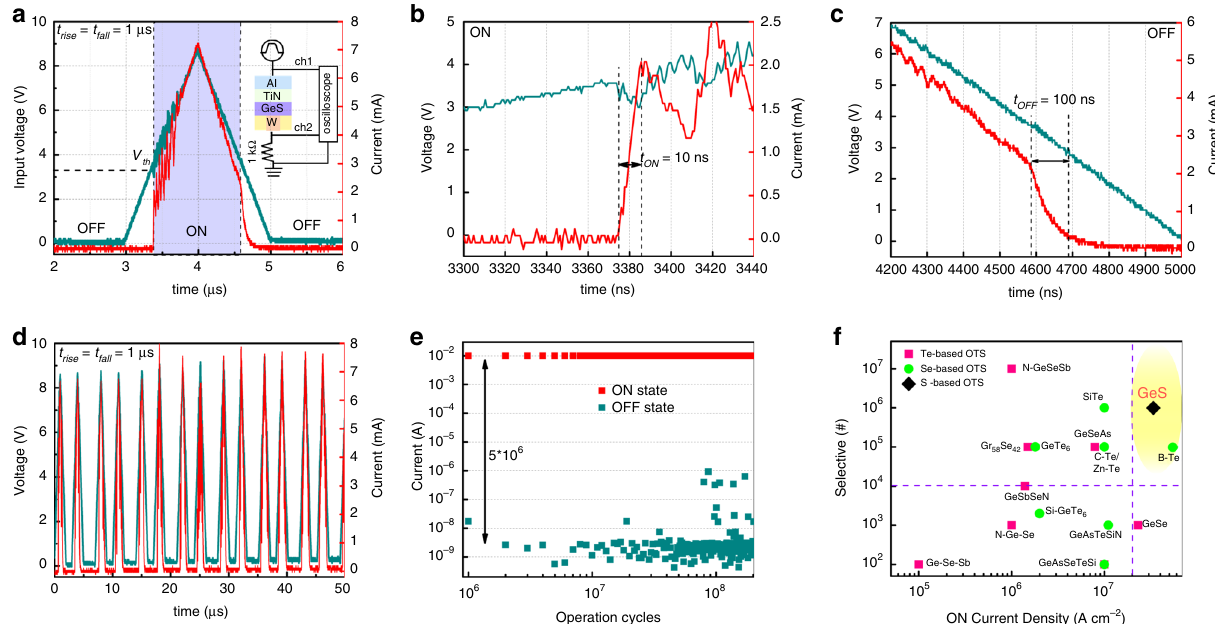
Fig. 2 Transient characterization and endurance of GeS OTS selector. a Dynamical transient response of the device under triangular voltage pulses with amplitude of 9 V and rising/falling edge of 1 μ s. The device shifts from OFF state to ON state within 10 ns and returns to OFF state within 100 ns. b , c Enlarged view of ON and OFF switching curves, respectively. d Dynamical response to multiple triangular pulses. e Endurance cycles of GeS device maintaining stable high- and low-resistance state. f Comparison of selectivity and J ON of reported OTS devices with our work 14,17,27 – 31 . The ON current density and selectivity for other OTS selectors were calculated from currents and device sizes reported in related works.